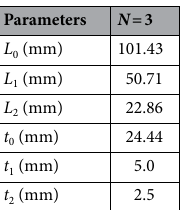
Table 1. Dimensions of 2D planar space-filling square fractal grid of N = 3.